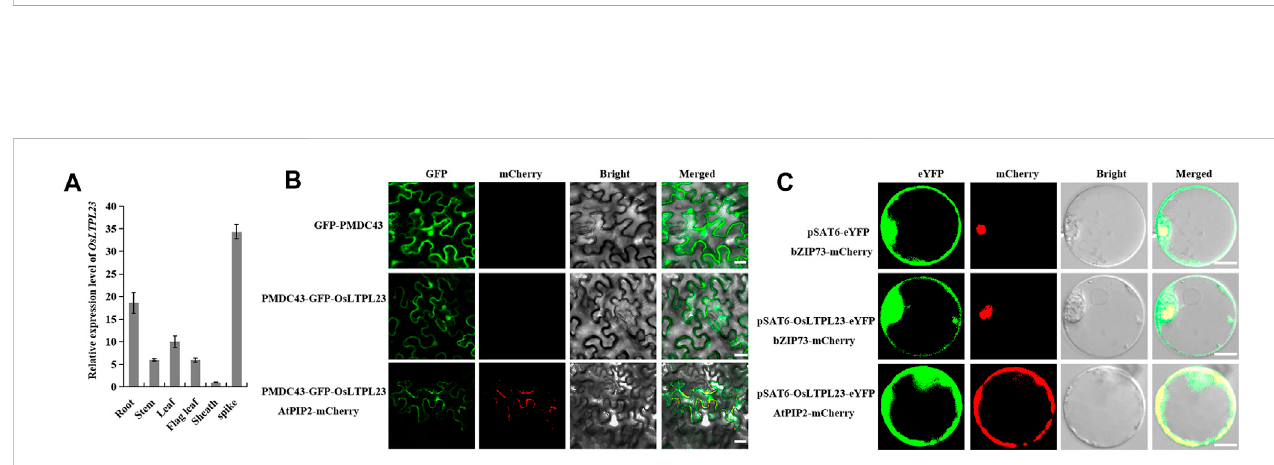
FIGURE 3 Tissue expression pattern and subcellular localization of OsLTPL23 . (A) OsLTPL23 transcription expression in various tissues of NIP using qRT-PCR. (B) Subcellular localization ofGFP-OsLTPL23fusionproteinin N.benthamiana epidermalcells.PlasmidsPMDC43andPMDC43-OsLTPL23wereintroducedinto tobacco leaf cells by Agrobacterium -mediated transformation, respectively. Scale bars, 20 μ m. (C) Subcellular localization of OsLTPL23-eYFP fusion protein in rice protoplast. Plasmids pSAT6-eYFP-N1 and pSAT6-OsLTPL23-eYFP-N1 were introduced into rice protoplast by PEG-mediated transformation, respectively. Scale bar, 10 μ m OsbZIP73 ( bZIP transcription factor , nucleus marker, Os09g0474000 ); AtPIP2A ( plasma membrane intrinsic protein 2A , At3g53420